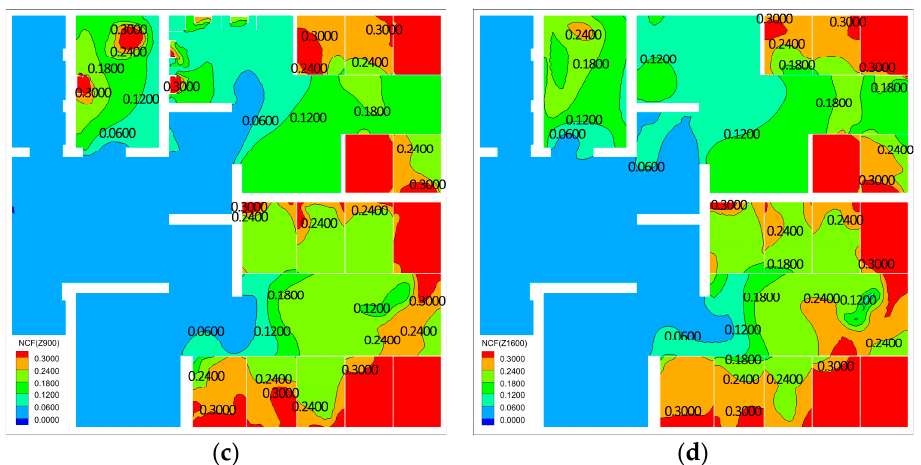
Figure 4. Concentration cloud map of pollutants in Scenario 2. ( a ) H 2 S concentration fraction (Z900); ( b ) H 2 S concentration fraction (Z1600); ( c ) NH 3 concentration fraction (Z900); ( d ) NH 3 con- centration fraction (Z1600).